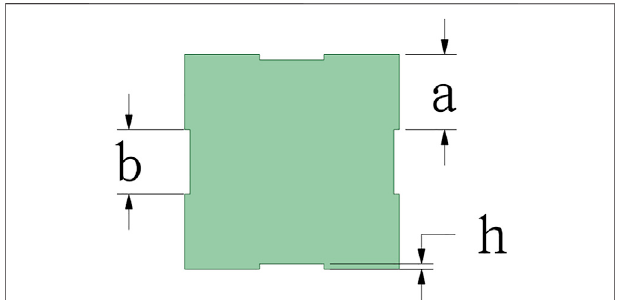
FIGURE 5 | Schematic diagram of square cylinder patch.